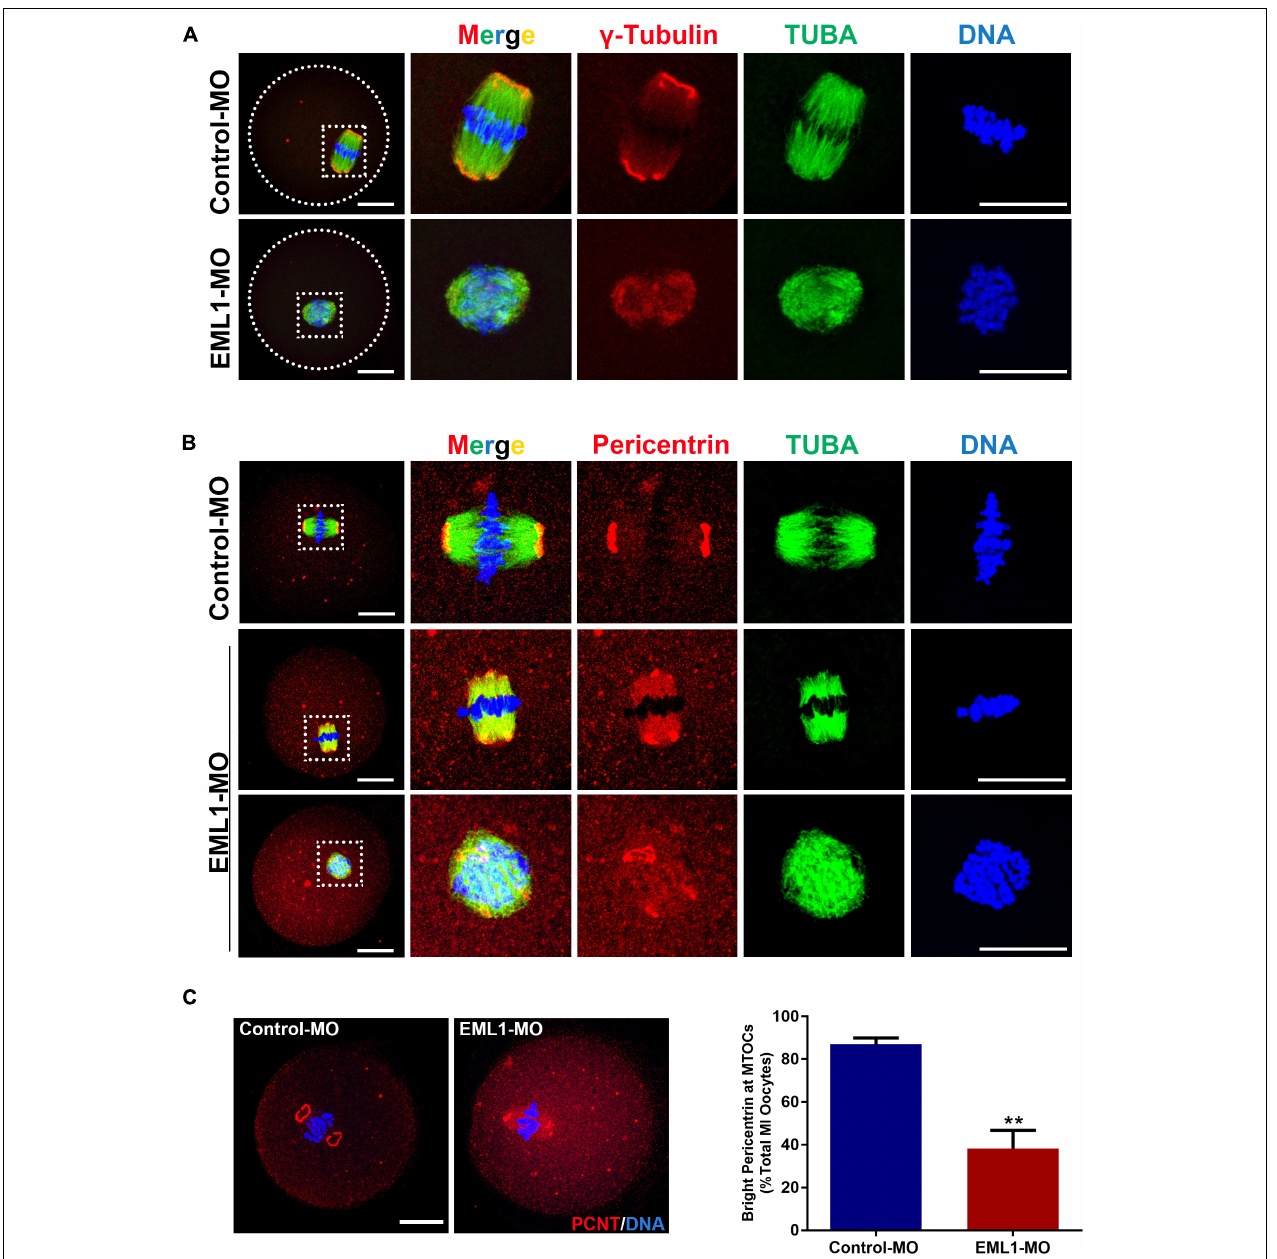
FIGURE 5 | Knockdown of EML1 in oocytes disrupts the normal localization of a MTOC-associated proteins to the spindle pole. (A) Representative images of MO-injected oocytes labeled with anti- γ -Tubulin (red) and anti- α -Tubulin (green). DNA was counterstained with Hochest 33342 (blue). (B) . Representative images of MO-injected oocytes labeled with anti-Pericentrin (red) and anti- α -Tubulin (green). DNA was counterstained with Hochest 33342 (blue). In both (A,B) , the far left panel indicate the whole-oocyte view of the staining. The magnified images of the boxed areas within the oocyte are listed on the right side. Scale Bar = 20 µ m. (C) Quantification of the percentage of oocytes with correct spindle pole Pericentrin (PCNT). ** P < 0.01, compared with the Control-MO group.